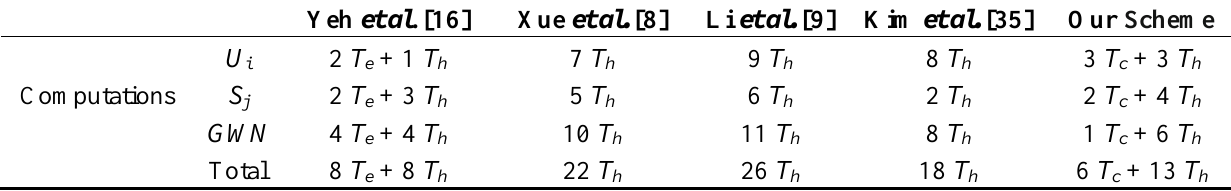
Table 2. The performance comparisons of the related schemes and the proposed scheme. Yeh et al . [16]